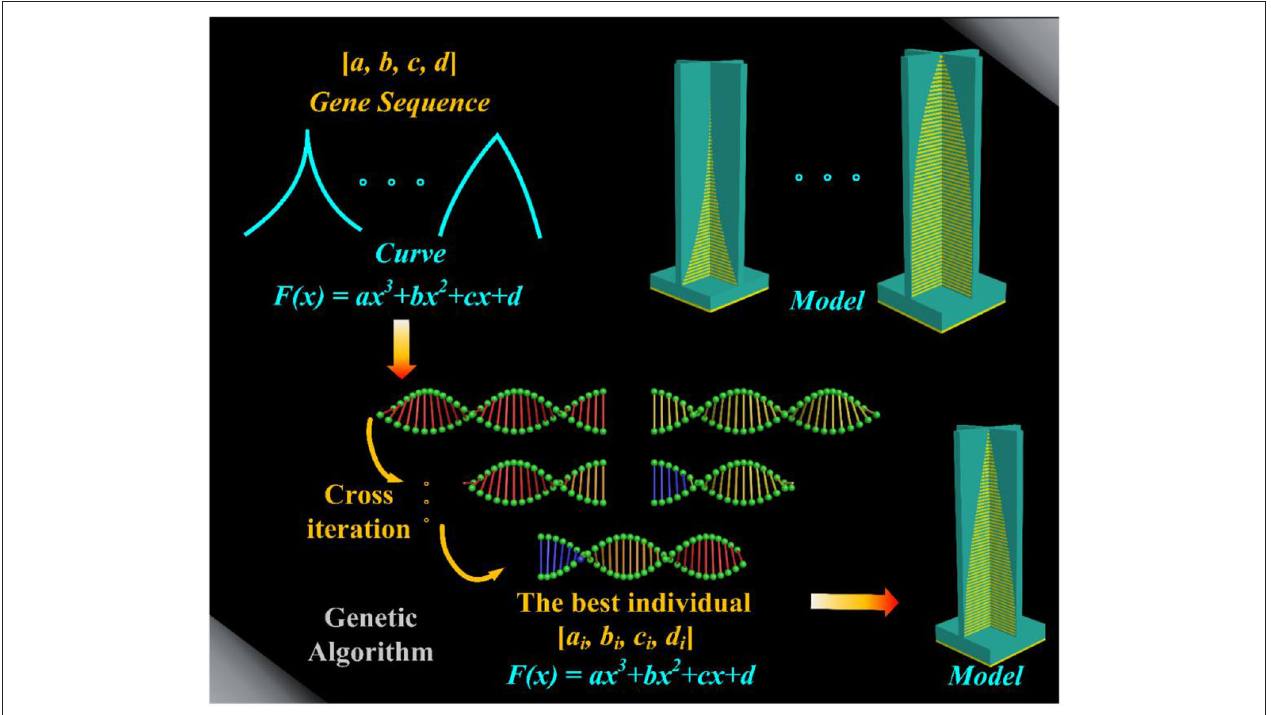
FIGURE 1 | Schematic diagram of this